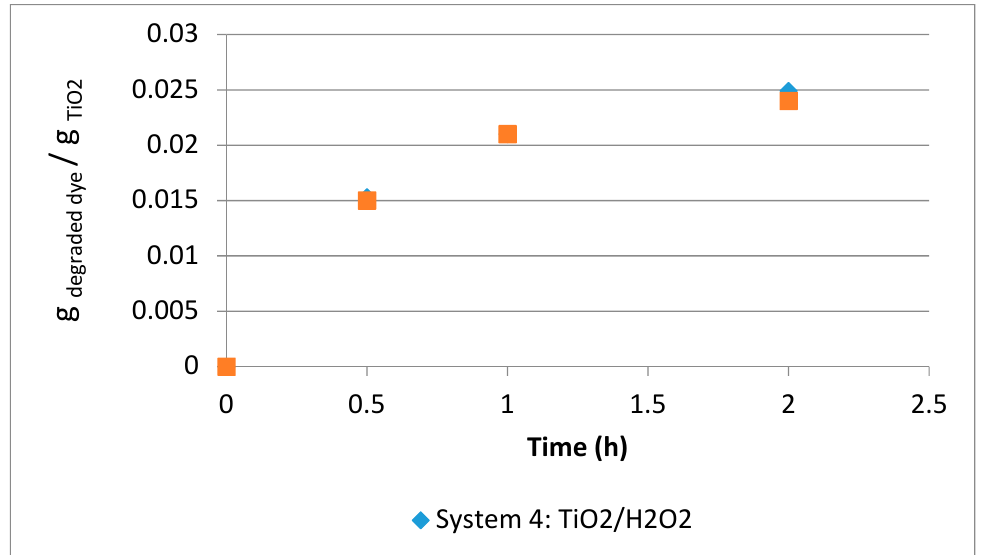
Figure 16. Comparison of the dye degradation curves for Systems 4 and 5.